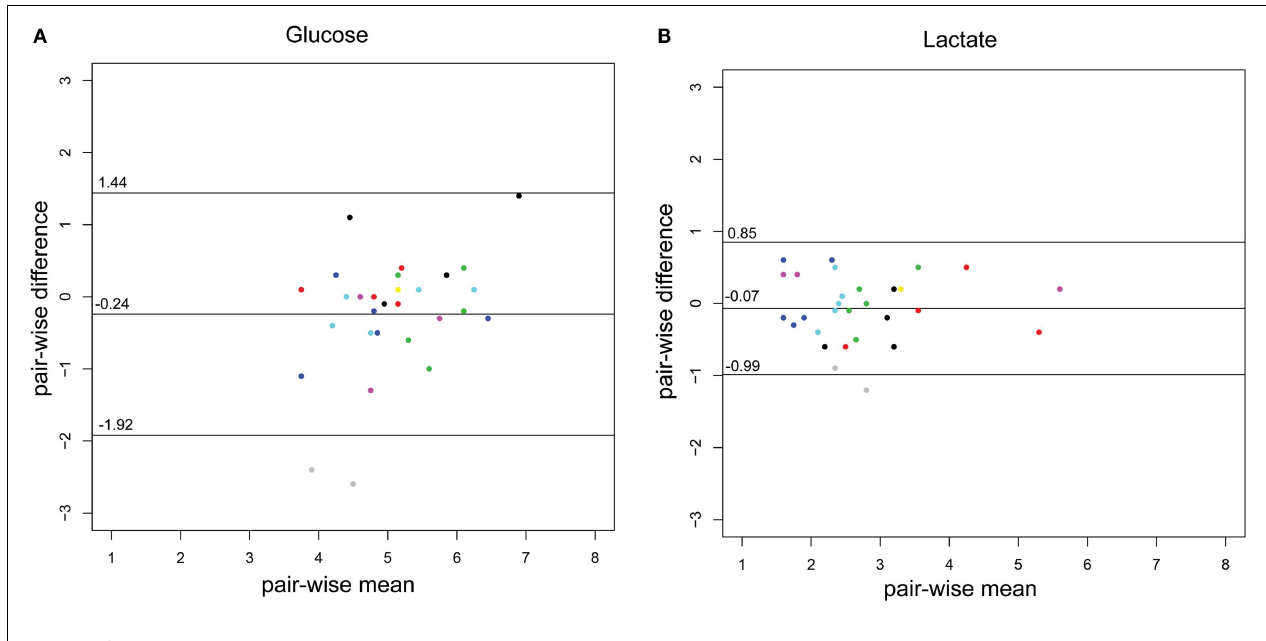
FIGURE 2 | Bland–Altman plots of the CSF-glucose and CSF-lactate samples ( n = 29) corresponding with MD-CSF glucose (A) and MD-CSF lactate (B) .The points are plotted with the difference between two observations (pair-wise difference) on the y -axis, and the mean of the two observations (mean-wise difference) on the x -axis.